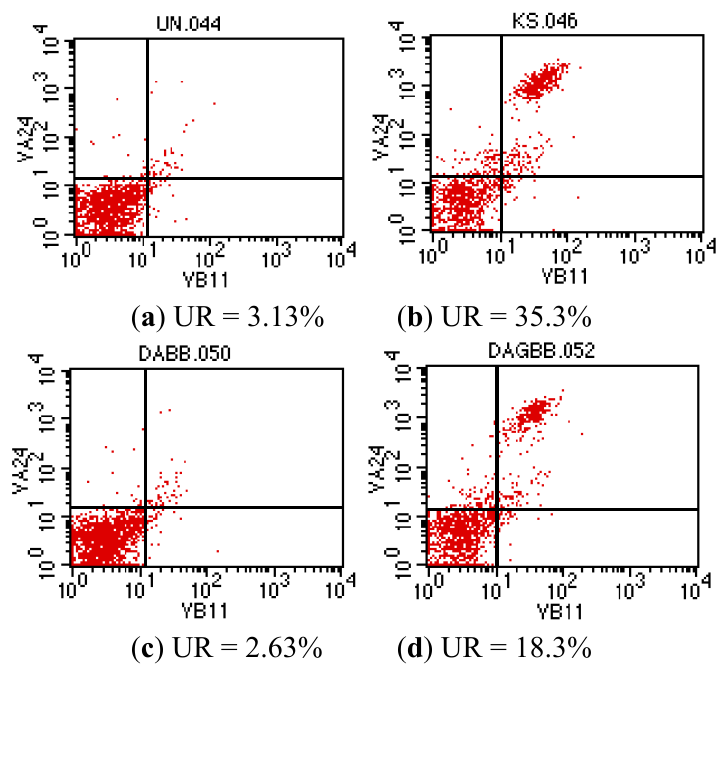
Figure 3. Potencies of analogs 18 and 19 for stimulation of human V  24+/V-  11+ NKT cell populations. Peripheral blood mononuclear cells (PBMC) from a normal healthy donor were incubated with each individual compound at a final concentration of 100 nM. After 14 days of culture, NKT cell frequencies were determined by flow cytometry. NKT cell frequencies were defined as the percentage of V  24+/V-  11+ cells among gated lymphocytes in the upper right (UR) corner for each case. Shown here are the profiles of PBMC harvested from 14-day cultures containing ( a ) vehicle alone (DMSO, UN); or ( b ) 100 nM of  -GalCer (KS); ( c ) analog 18 (DABB); or ( d ) analog 19 (DAGBB), as